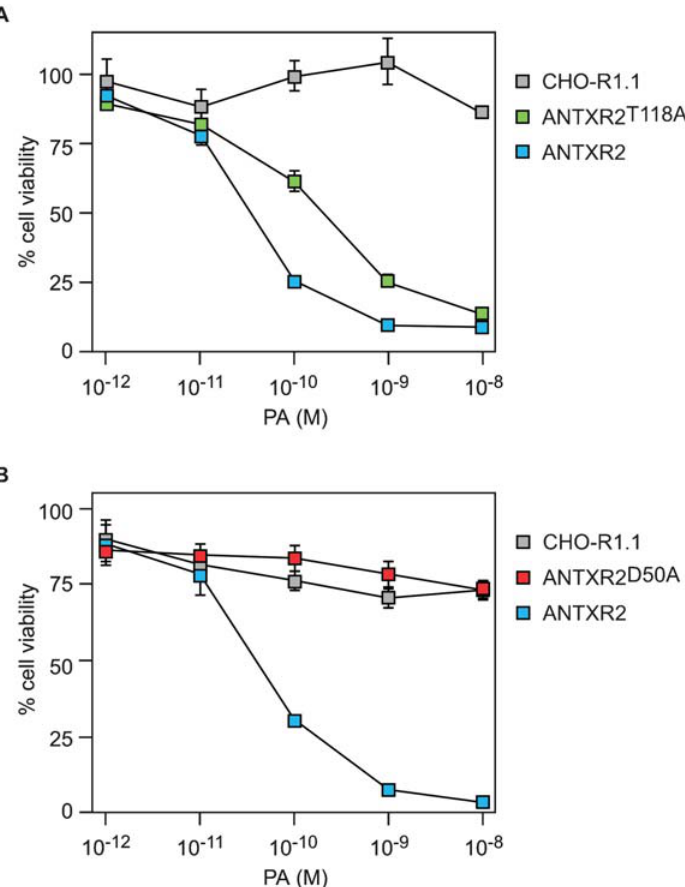
Figure 4. The cell surface T118A mutant ANTXR2 supports intoxication. Triplicate samples of the cells shown in Fig. 2 were incubated with 10 2 10 M LF N -DTA and varying concentrations of PA and cell viability was measured as described in the Fig. 3 legend.